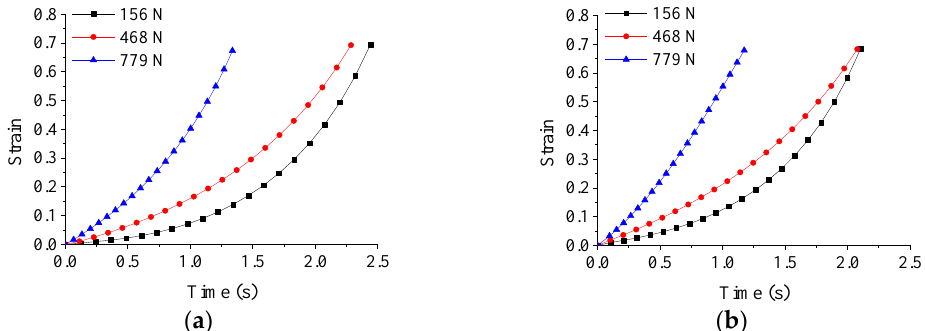
Figure 7. The variations of strain with time under different pressing forces at the following molding temperatures: ( a ) 382 °C and ( b ) 392 °C.